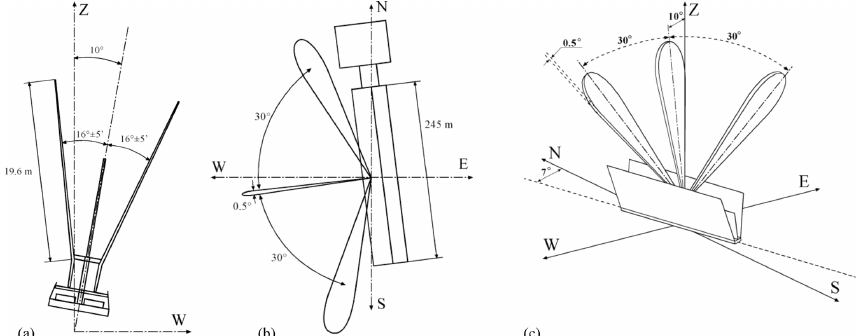
Figure 7. Dimensions and antenna pattern of the IISR. Antenna dimensions (a, b) ; AP formation (c)